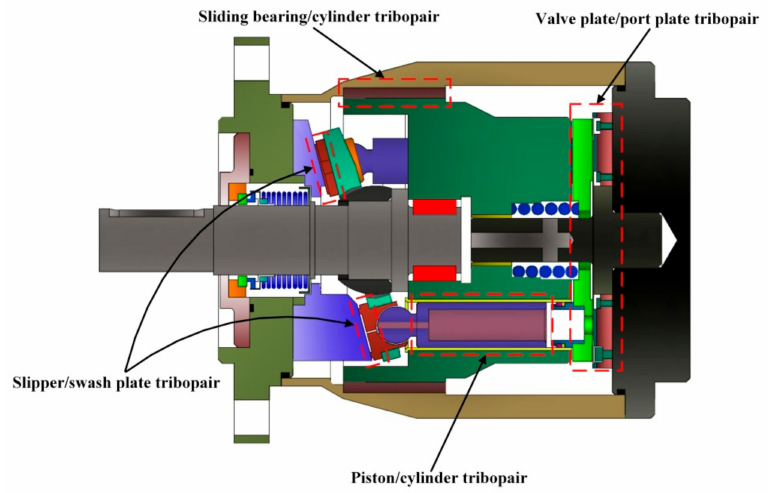
Figure 1. Configurations of a water hydraulic axial piston